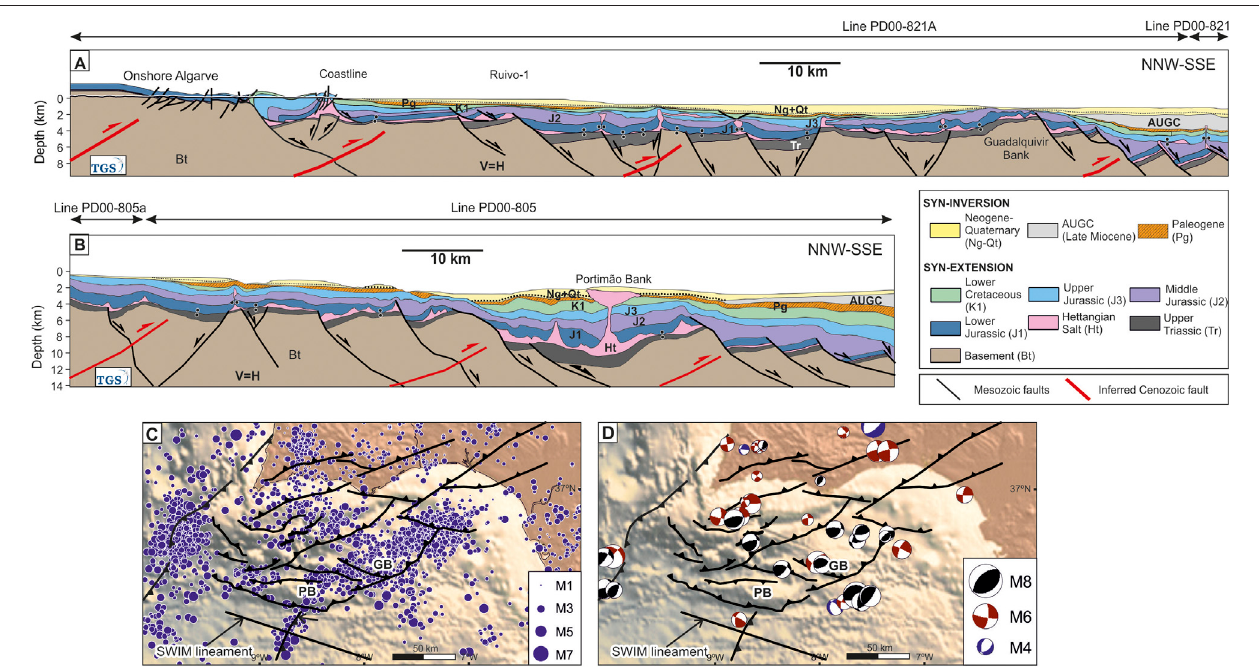
FIGURE 3 | Cross-sections through the Algarve Basin showing the major ontractional structures responsible for the inversion of the SW Iberian margin. (A) Interpreted seismic section through the central Algarve Basin, including interpretation of the onshore basin. (B) Interpreted seismic section through the western Algarve Basin. Pairs of black dots represent salt welds. See Figure 2 for location. Modi fi ed after Ramos et al. (2017a). See this reference for further discussion on the seismic interpretation and supplementary data for seismic sections. (C) Location of earthquake epicentres in the SW Iberian margin in relation with the thrust fault system describedinthetext inmore detail. (D) Location offocalmechanismscompiledfrom severalearthquakes: red forstrike-slip faulting,black forthrustfaulting,and blue for normal faulting in relation with the thrust faults of SW Iberia. Modi fi ed after Palano et al. (2013) and Ramos et al. (2017a). GB: Guadalquivir Bank; PB: Portimão Bank.